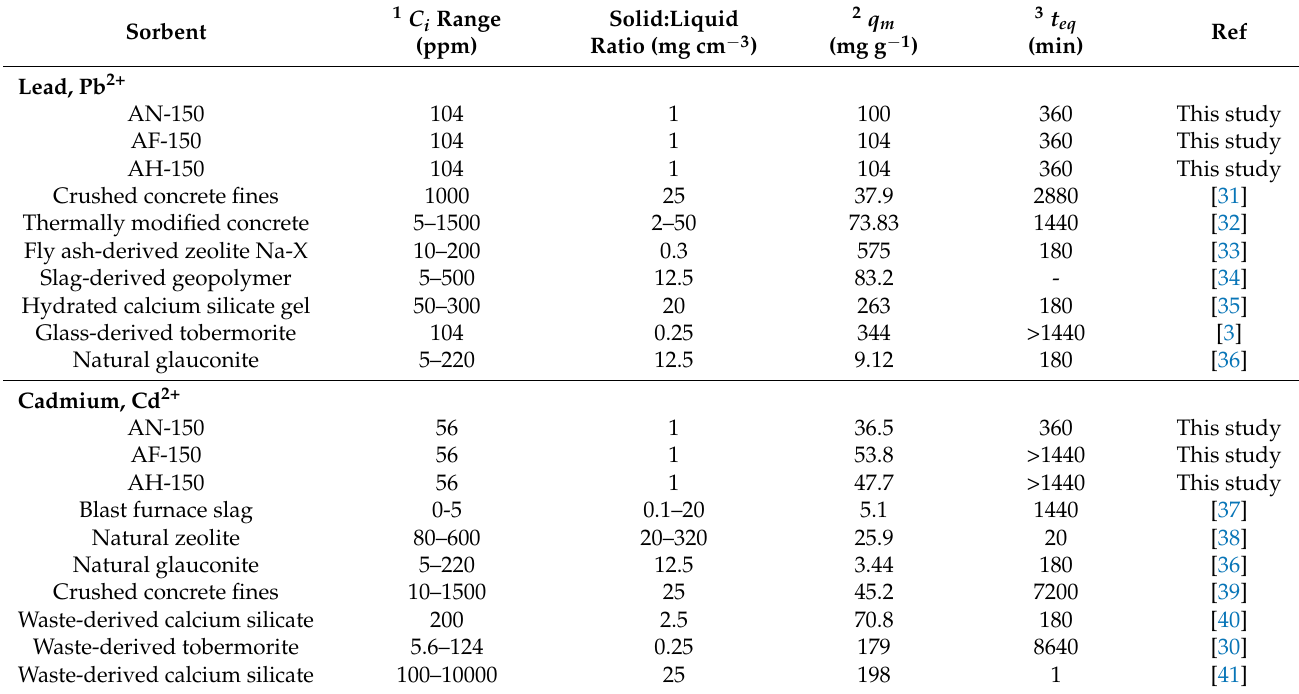
Table 5. Comparison of the uptakes of Pb 2+ and Cd 2+ by AN-150, AF-150, AH-150 and those of other low-cost and waste-derived inorganic